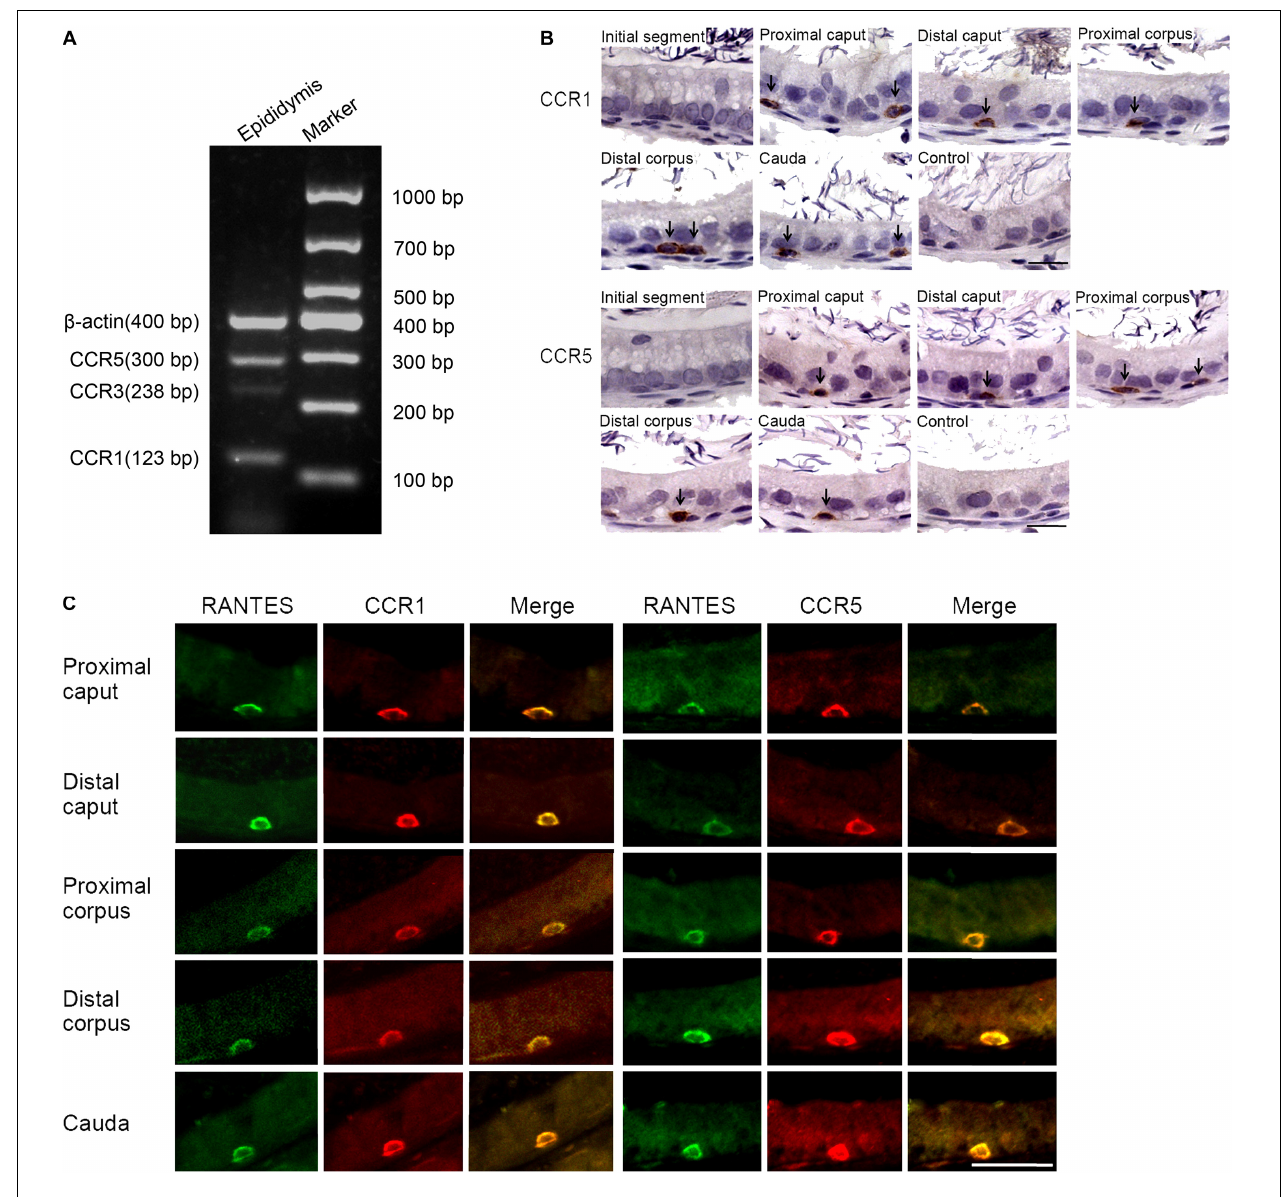
FIGURE 2 | Expression of RANTES receptors CCR1, CCR3 and CCR5 in the adult rat epididymis. (A) Expression of CCR1, CCR3 and CCR5 in rat epididymis were detected by RT -PCR. (B) Immunohistochemistry of CCR1 and CCR5 in rat epididymis. Black arrows: positive signals for CCR1 or CCR5. (C) Double IF staining